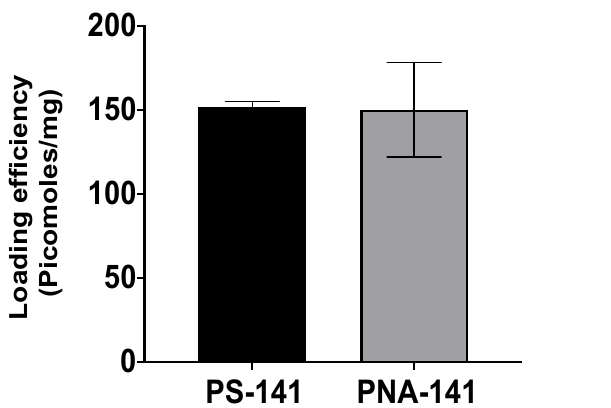
Figure 5. PS and PNA loading analysis. Data are shown as mean ± standard error mean (SEM).